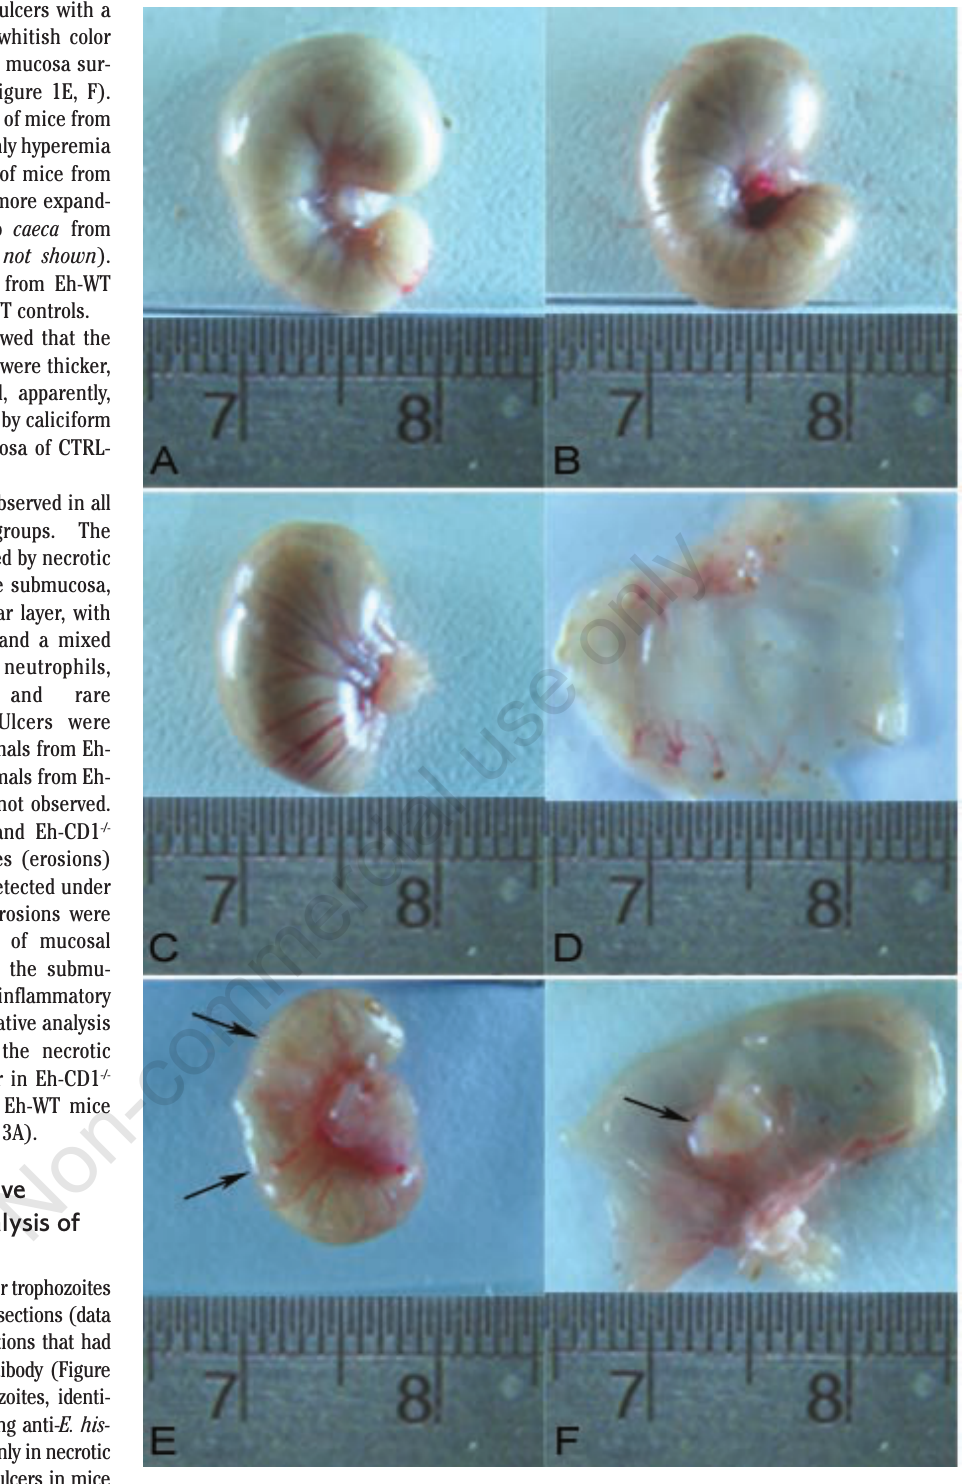
Figure 1. Caeca of C57BL/6 wild type and C57BL/6 CD1 -/- mice inoculated or not with Entamoeba histolytica trophozoites. A) non-infected-wild type and B) non-infected-CD1 - /- groups: normal aspect of the caecum; C) Entamoeba-wild type group: caecum with hyperemia; D) aspect of the caecal mucosa of Figure 1C after longitudinal section show- ing some hyperemic regions; E) Entamoeba-CD1 -/- group: whitish ulcer (arrows indicate ulcers), hyperemic serosal surface; F) aspect of the caecal mucosa of Figure 1E after lon- gitudinal section allowing visualization of an ulcer (arrow) in the mucosal surface sur- rounded by areas of